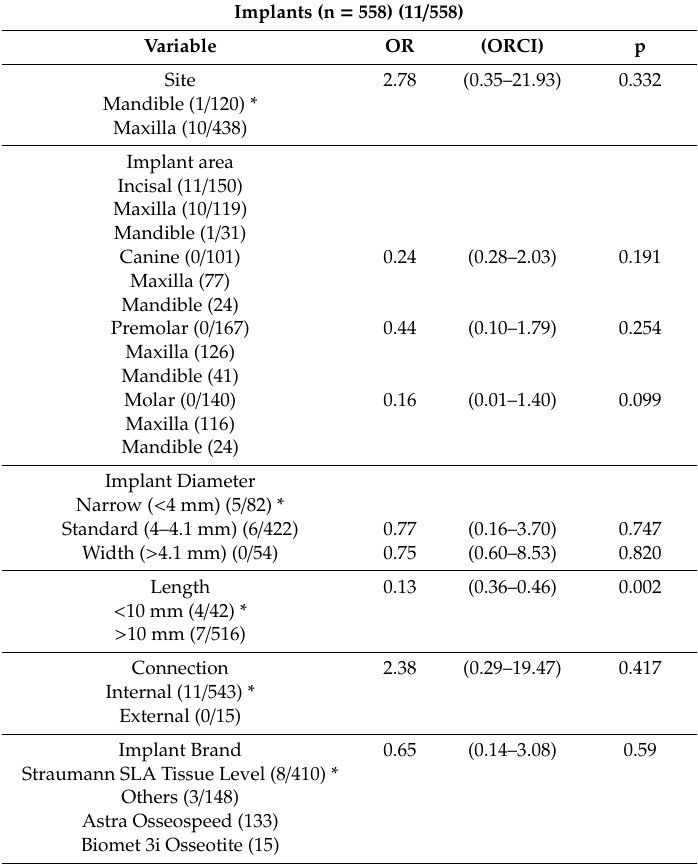
Distribution of periimplantitis complications in the sample in relation to p implant-based